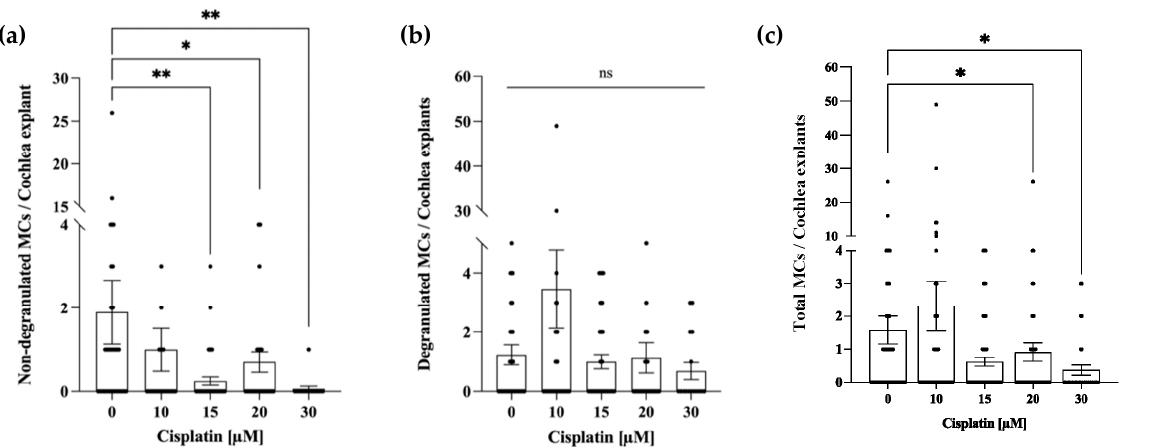
Figure 3. Cisplatin decreases the number of non-degranulated MCs and causes a reduction of cochlear MCs at higher concentrations. The control group (n = 9) was cultured for 24 h in a culture medium. The remaining groups were exposed to 10 µM (n = 10), 15 µM (n = 4), 20 µM (n = 12), or 30 µM (n = 4) of cisplatin for 24 h. ( a ) The absolute number of non-degranulated MCs per explant (spiral limbus and LW). ( b ) The absolute number of degranulated MCs per explant (spiral limbus and LW). ( c ) The total number of MCs per explant (containing spiral limbus with OC and LW as well non-degranulated and degranulated MCs). The average number of MCs per naive explant was 1.58 ± 0.42. The data represent four independent experiments and are reported as a mean ± SEM. “ns” indicates not significant ( p > 0.05); * p < 0.05; ** p < 0.01; (Kruskal–Wallis test with Dunn’s multiple comparison test).